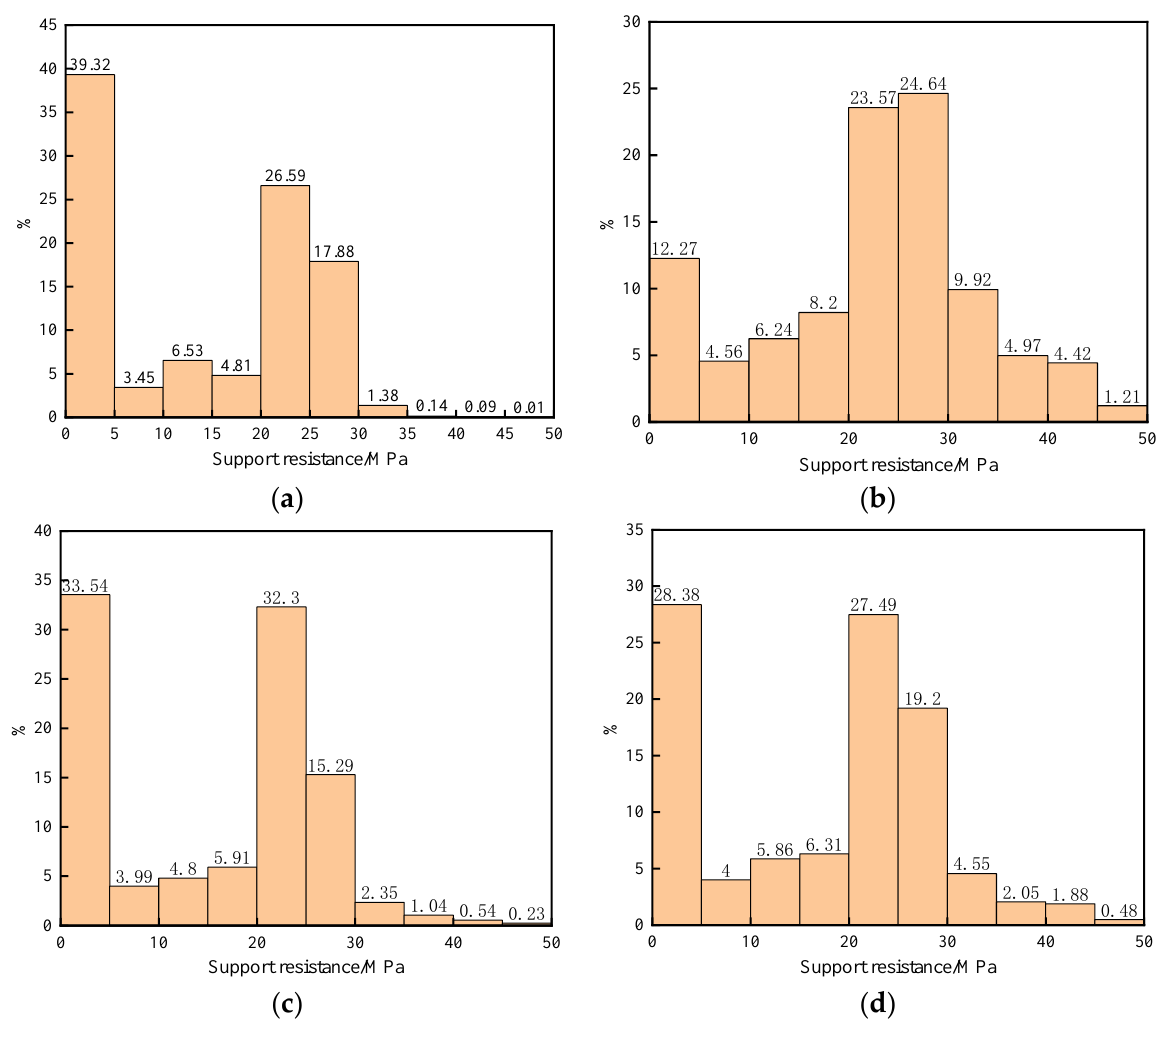
Figure 14. Statistical histogram of load frequency analysis. ( a ) Pressure monitoring of fully mecha- nized supports (upper part). ( b ) Pressure monitoring of fully mechanized supports (middle part). ( c ) Pressure monitoring of fully mechanized supports (lower part). ( d ) Integral pressure monitoring of fully mechanized supports.